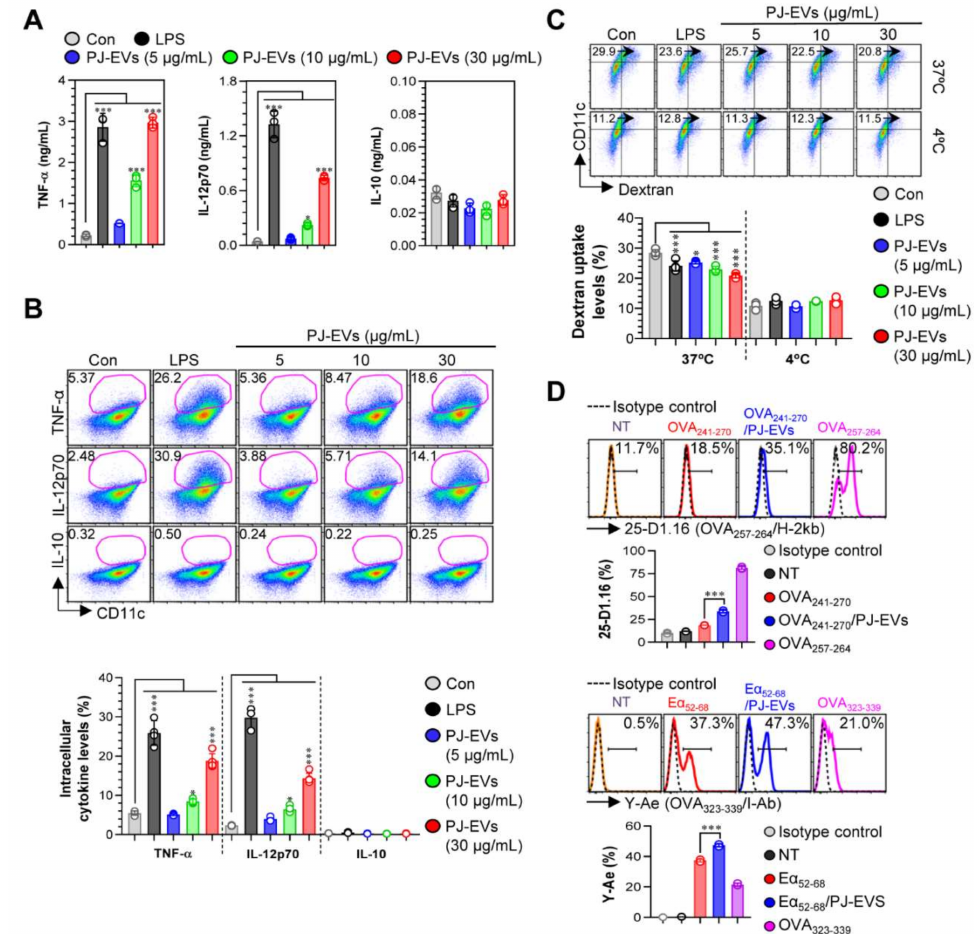
Figure 3. Cytokine production and antigen-uptake and antigen-presenting abilities of DCs stimulated with PJ-EVs. ( A ) Levels of TNF- α , IL-12p70, and IL-10 in the culture supernatant were analyzed using ELISA. ( B ) Intracellular cytokine levels of pro- (TNF- α and IL-12p70) and anti-inflammatory (IL-10) cytokines in untreated and lipopolysaccharide (LPS)- or PJ-EV-treated DCs. The mean fluorescence intensity of intracellular cytokines in CD11c + cells is shown in each panel. ( C ) DCs were stimulated with PJ-EVs or LPS for 18 h and cultured with dextran at 37 or 4 ◦ C for 30 min. These cells were labeled with anti-CD11c antibody and subjected to FACS analysis for detection of dextran uptake. ( D ) Untreated or LPS and PJ-EV-treated cells were treated with OVA 241–270 (10 µ g/mL) or E α 52–68 (20 µ g/mL) for 24 h. After incubation, each cell was labeled with anti-CD11c, anti-25-D1.16, or anti-Y-Ae mAbs for 15 min. Positive controls for antigen presentation, OVA 257–264 (5 µ g/mL) or OVA 323–339 (5 µ g/mL), were used. Histogram data and bar graphs show the expression of the OVA 257–264 /H-2Kb and OVA 323–339 /I-Ab in the gated CD11c + population. Bar graph data are shown as the mean ± SD (n = 3 samples) of three representative experiments. * p < 0.05, or *** p < 0.001. SD: standard